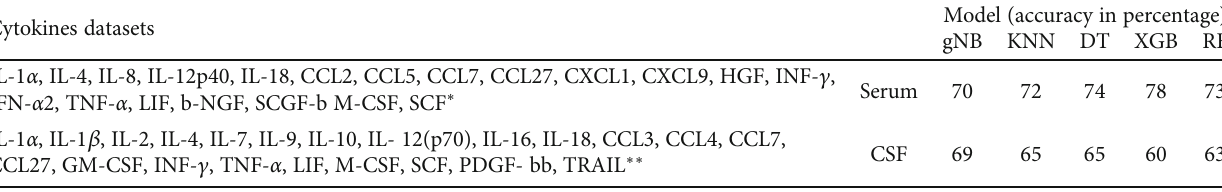
Table 4: Di ff erent model accuracy to classify MS.